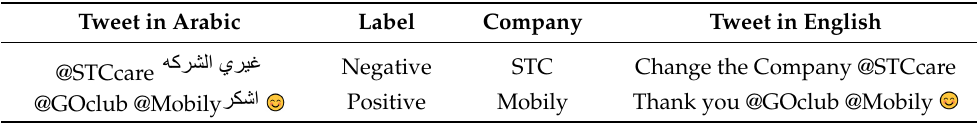
Table 5. Subset of the AraCust corpus before pre-processing.